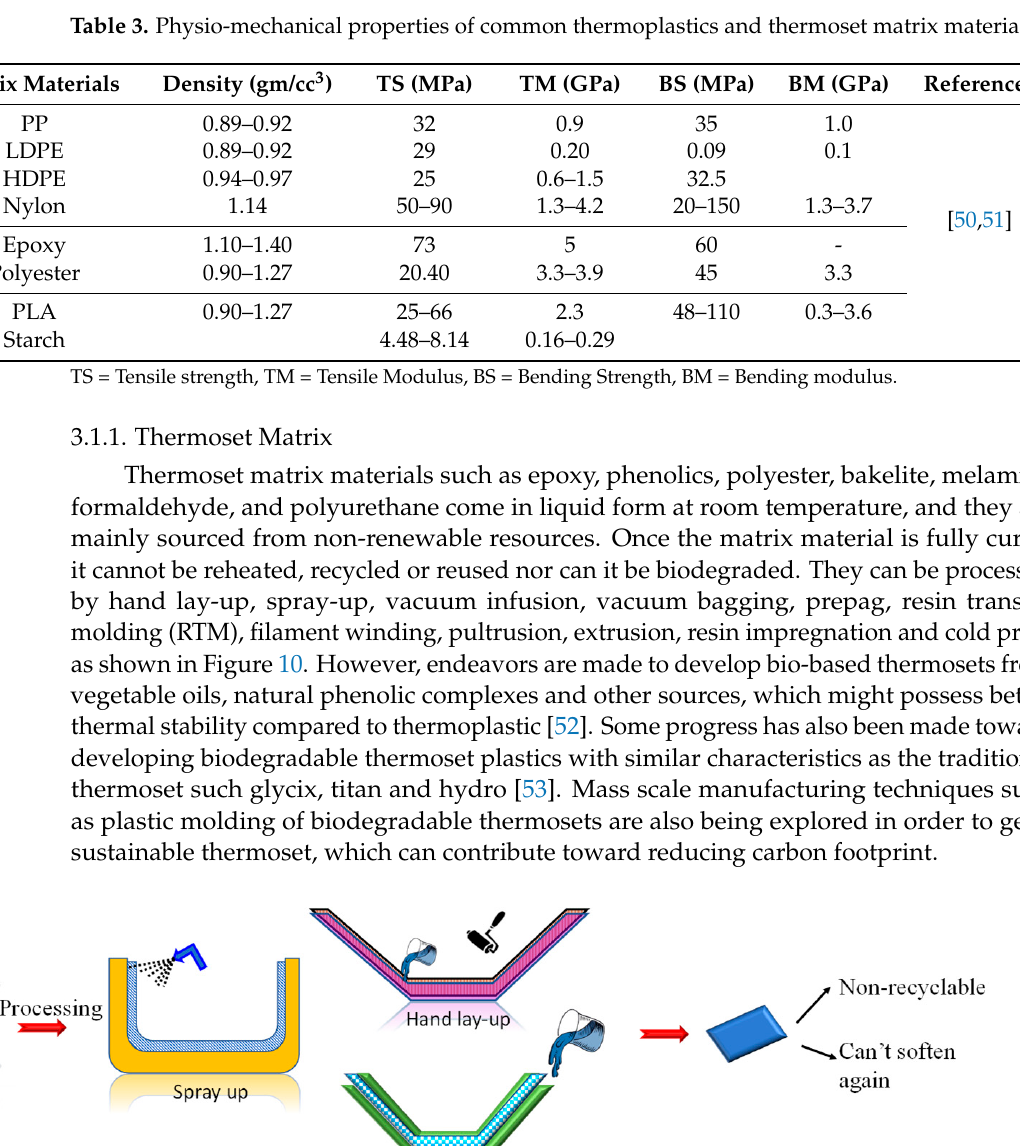
Figure 11. Different categories of thermoplastics and their popular applications. 3.2. Jute Fiber as Reinforcement in Composites Jute fibers in the form of particles (macro, micro or nano), fiber (short < 5 mm; semi long > 5 mm; long), fabrics (Plaine, twill and Satin) and nonwoven can be used to manu- facture composites depending on the applications and performance requirements. Figure 12 presents different forms of the jute fiber, that will influence the properties of the result- ing composite material.